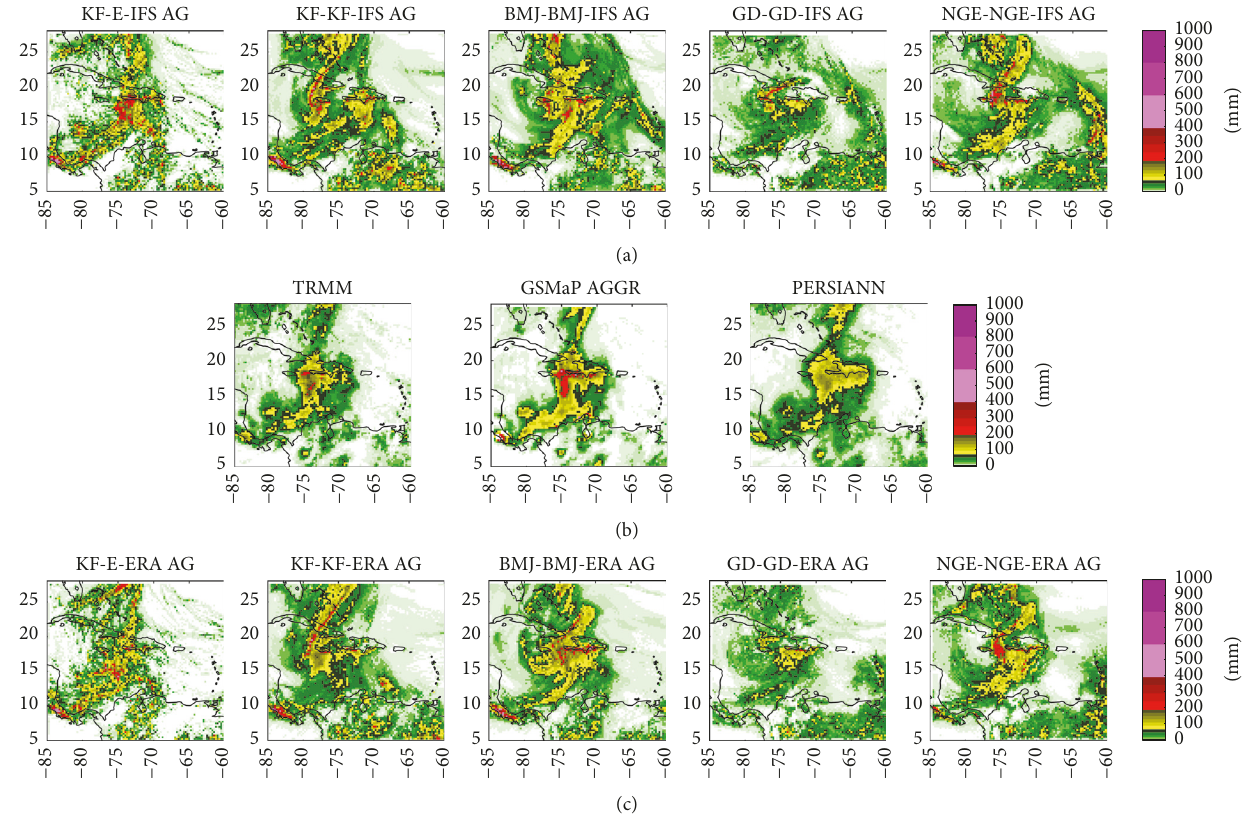
Figure 6: Rainfall depth from 00UTC on 4 November to 00UTC on 6 November 2010. Satellite observations (TRMM 3B42, GSMaP, and PERSIANN) in (b) simulations using KF-E, KF-KF, BMJ-BMJ, GD-GD, and NGE-NGE, respectively, in (a) those fed with IFS and in (c) those with ERA-Interim.